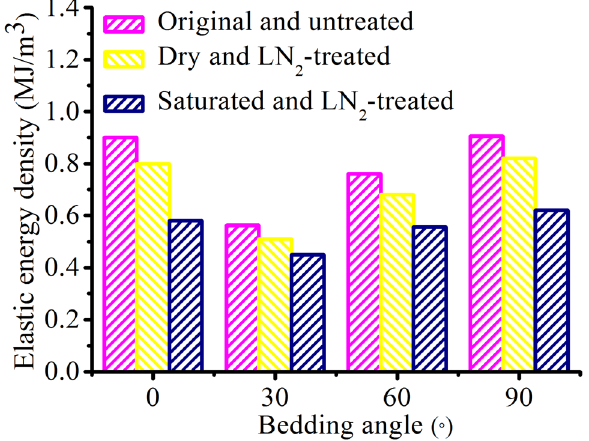
Fig. 14 Energy storage limit of different bedding shales before and after LN 2